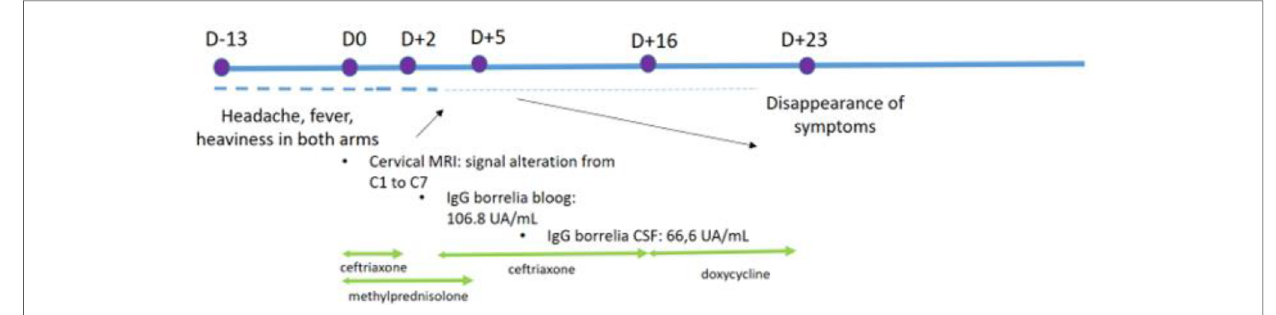
FIGURE 2 Summary of the clinical case in the presentation of a timeline. D0 corresponds to the diagnosis of transverse myelitis; ↗ to an increase in symptoms; ↘ to a decrease in